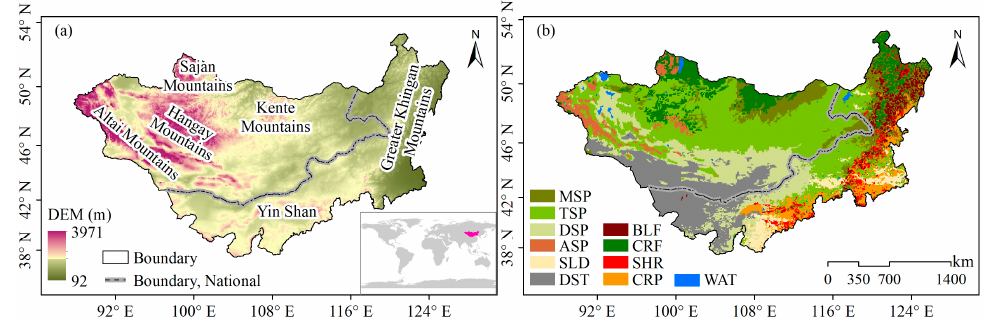
Figure 1. The MP’s topographic map ( a ) and the distribution of surface cover type ( b ). Note: MSP (meadow steppe), TSP (typical steppe), DSP (desert steppe), ASP (alpine steppe), SLD (sandy land), DST (desert), BLF (broad-leaved forest), CRF (coniferous forest), SHR (shrub), CRP (cropland), and WAT (water body).